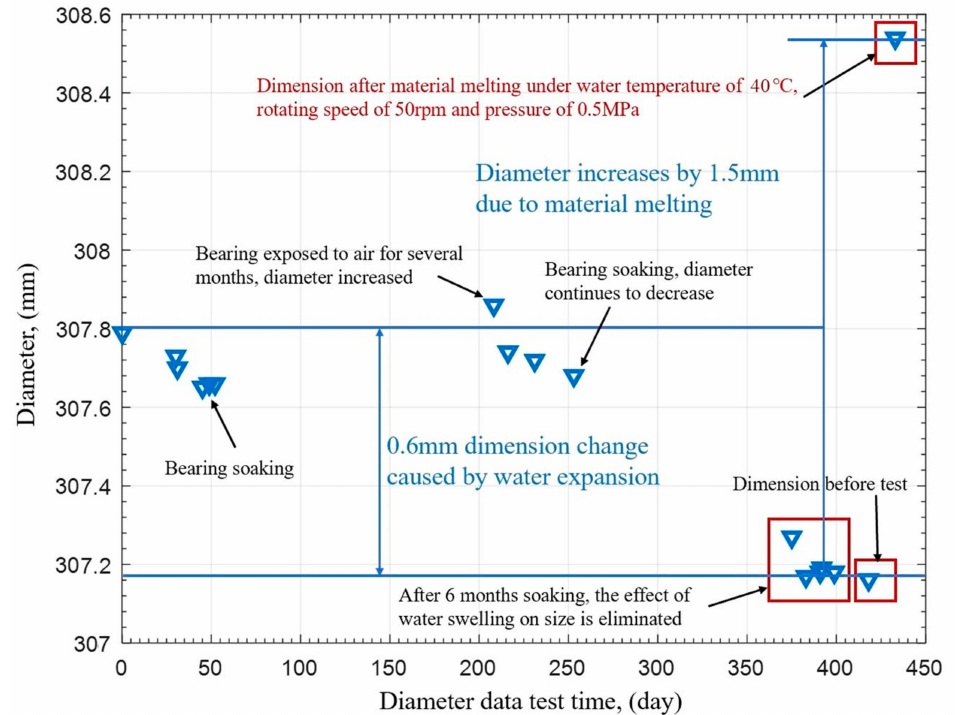
Figure 12. Changing of bearing diameter during whole